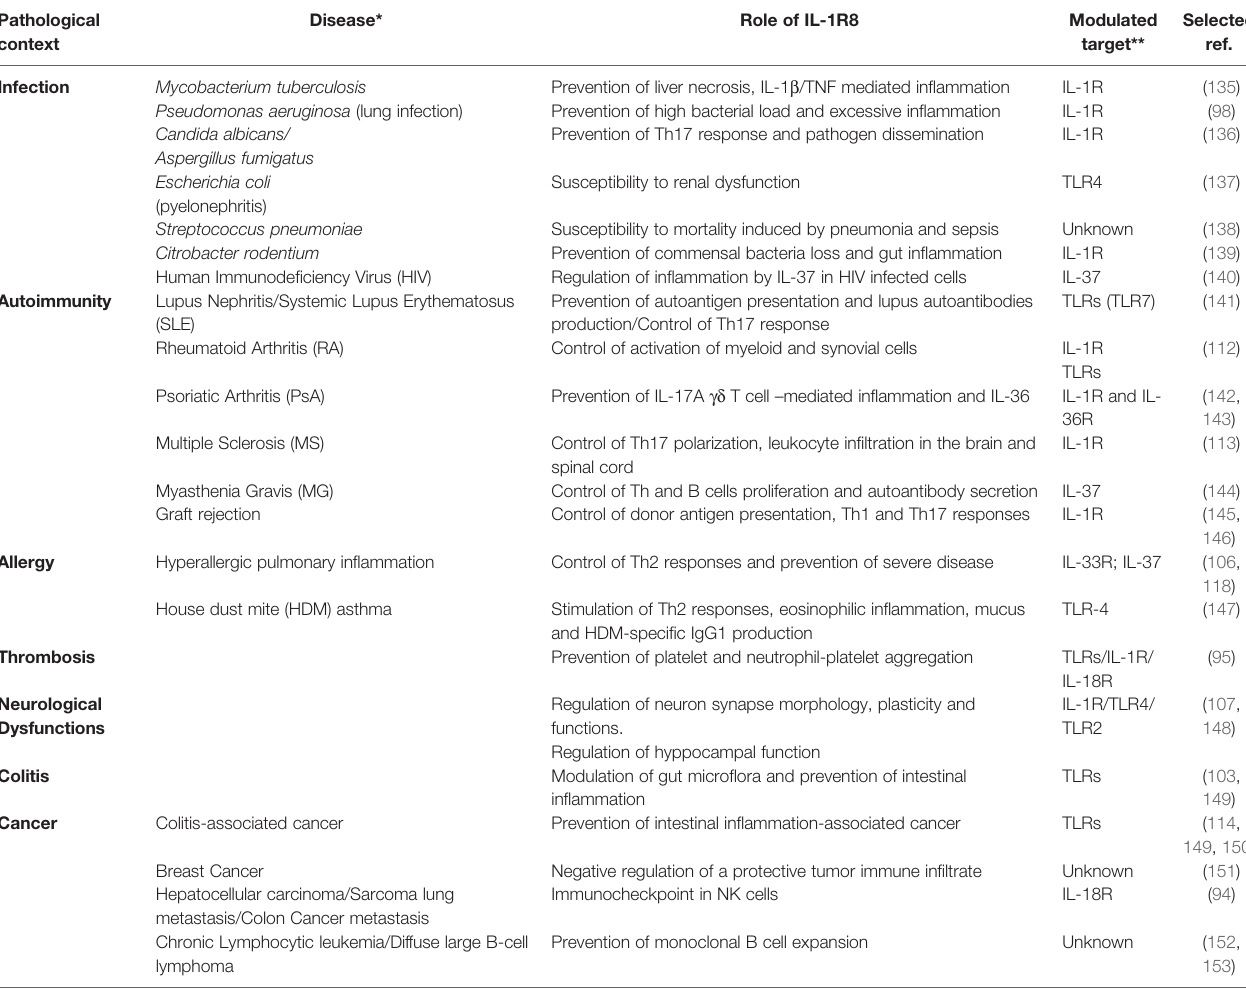
TABLE 1 | Pathophysiological roles of IL-1R8 in disease. Pathological